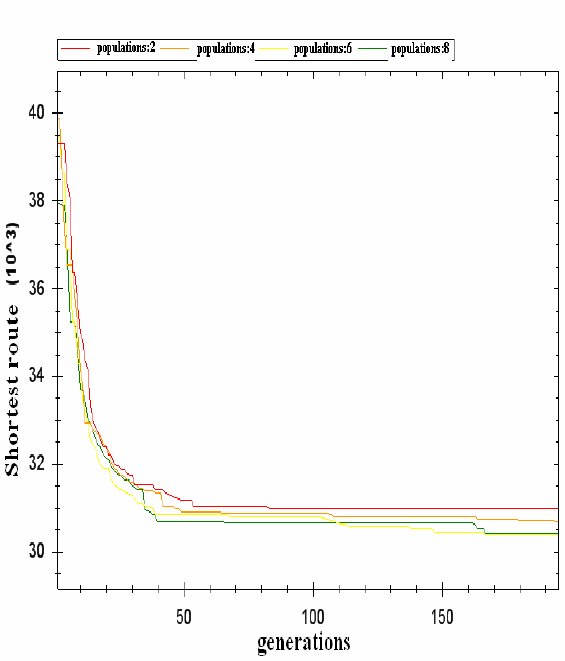
Figure15. The average result 7 of TSP benchmark instances Chn144 by different number of